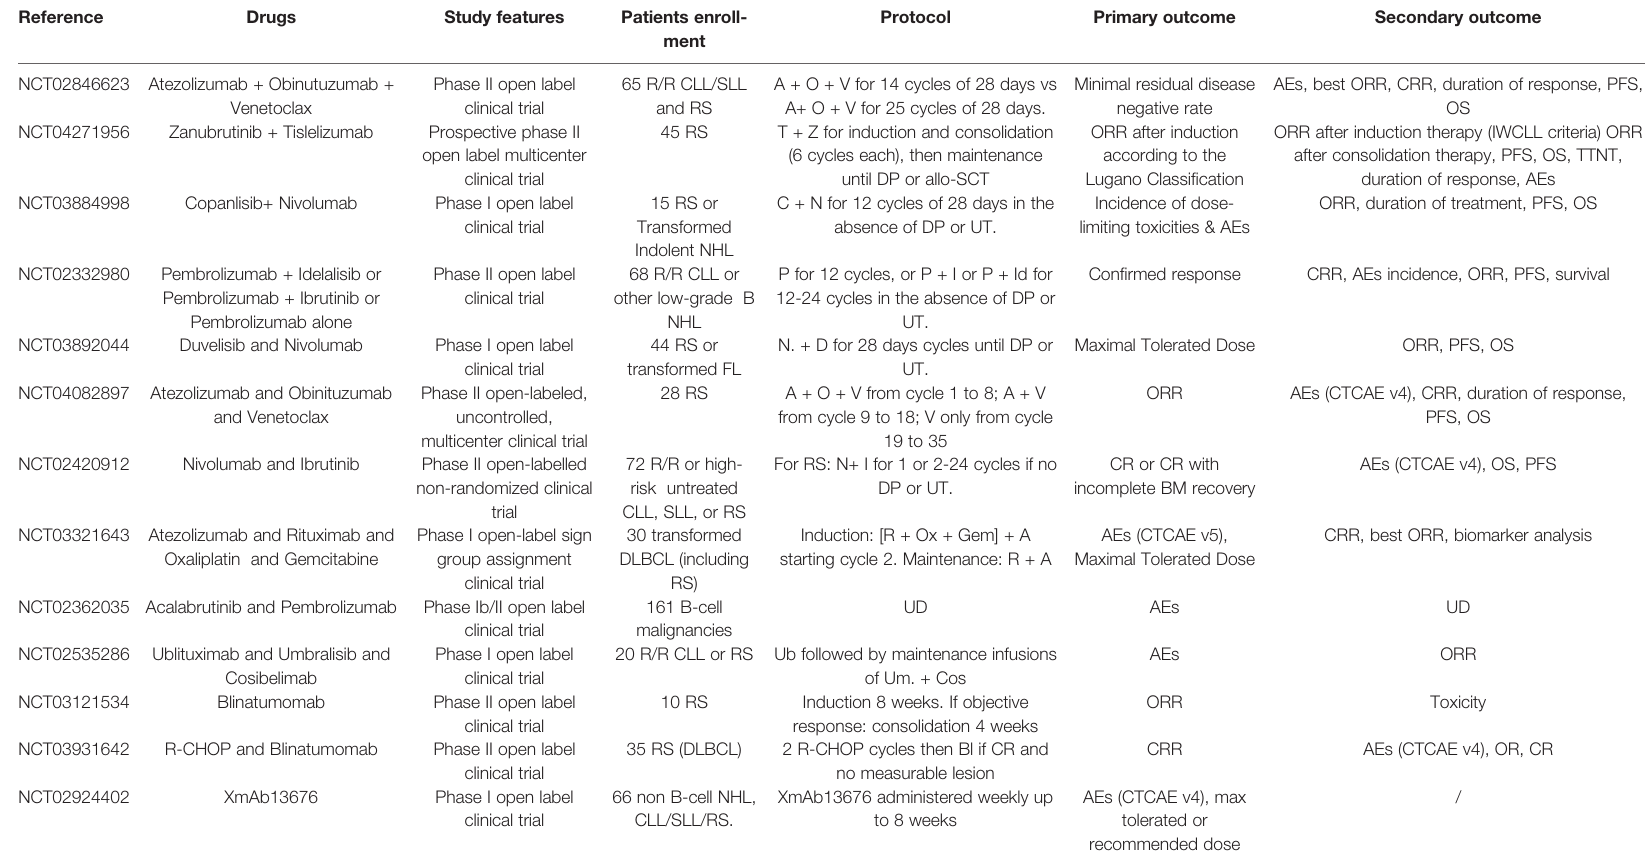
TABLE 3 | Ongoing clinical trials in